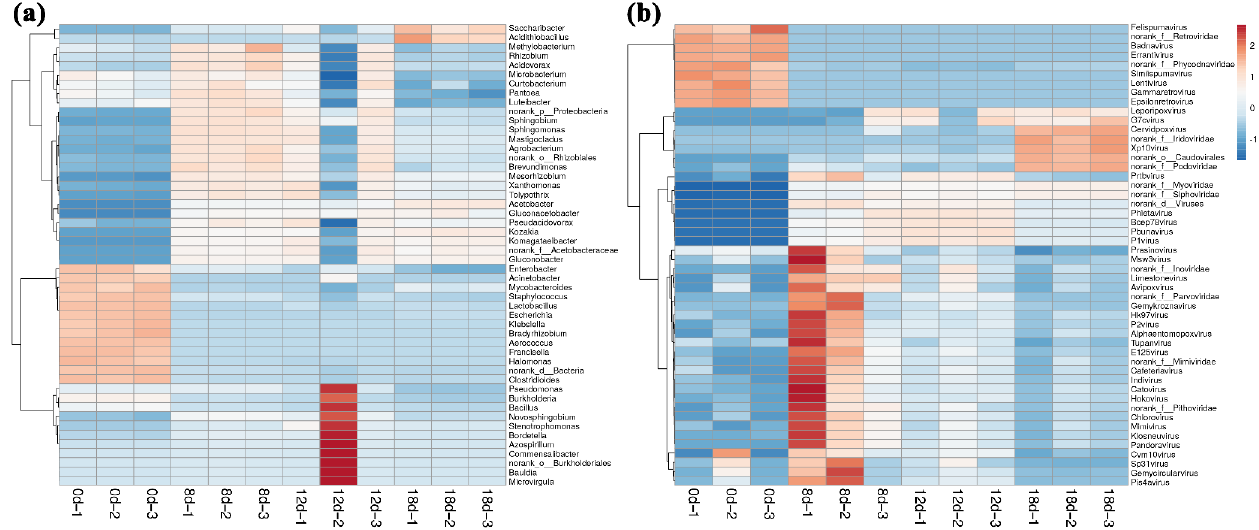
Figure 3. Dynamic changes in bacterial and viral community structure (at genus level) in vinegar Pei during acetic acid fermentation (( a ) bacteria, ( b ) virus).